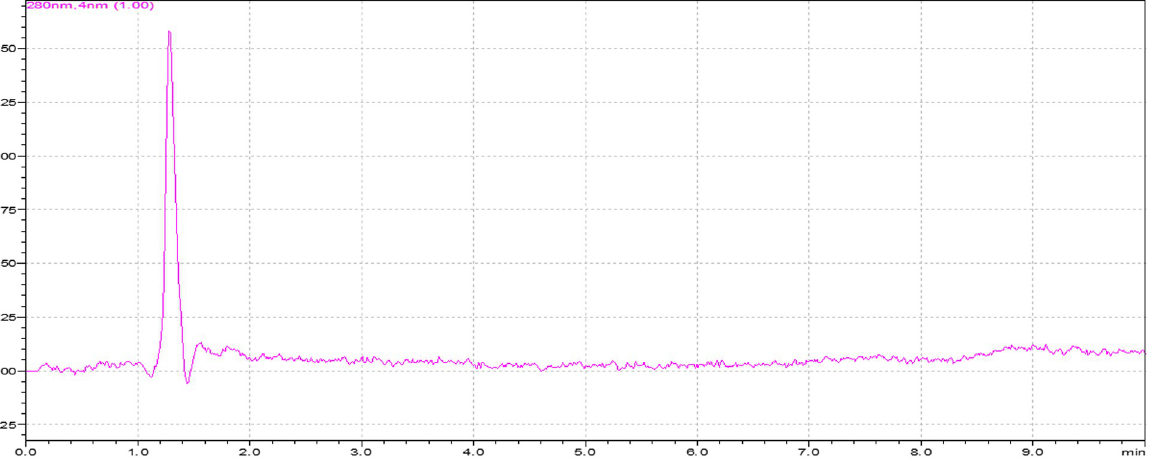
Fig 3. Chromatogram of placebo on the developed